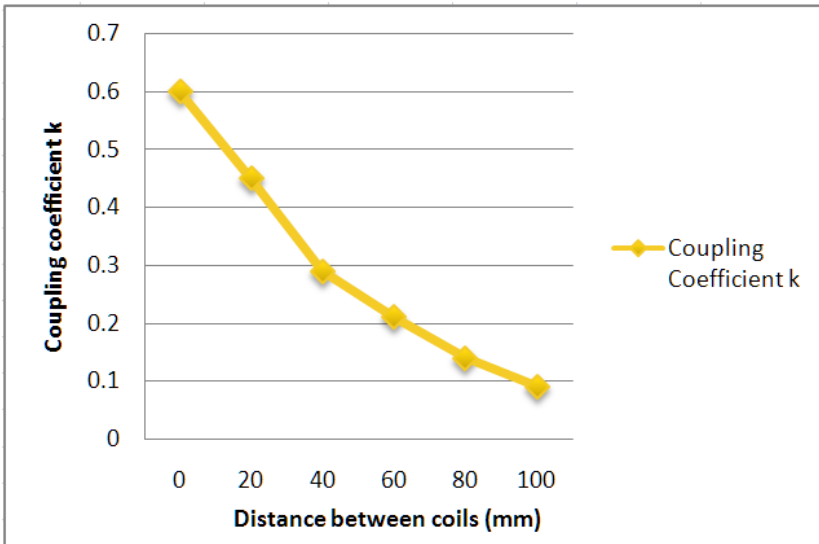
Figure 10. Coupling coefficient variation across distance.